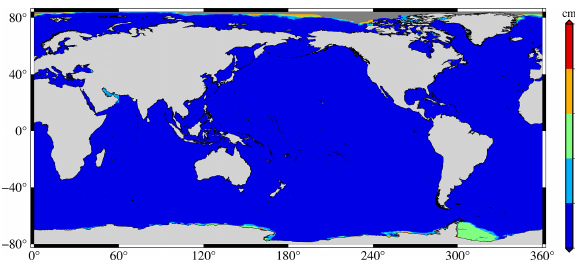
Figure 9. Formal error of the SDUST2020